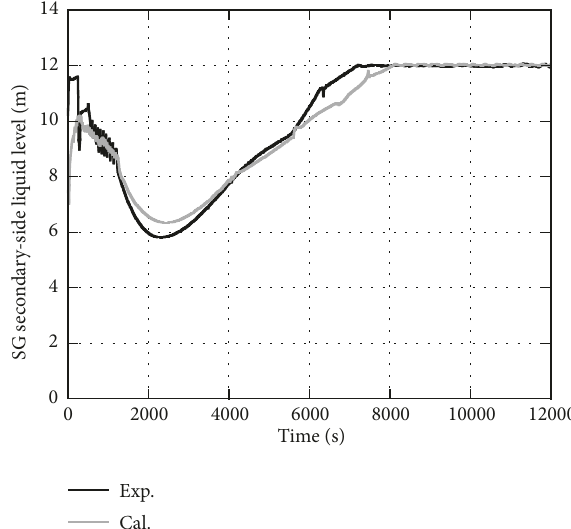
Figure 17: TR-LF-17test and RELAP5 results for SG secondary-side collapsed liquid level in loop A.